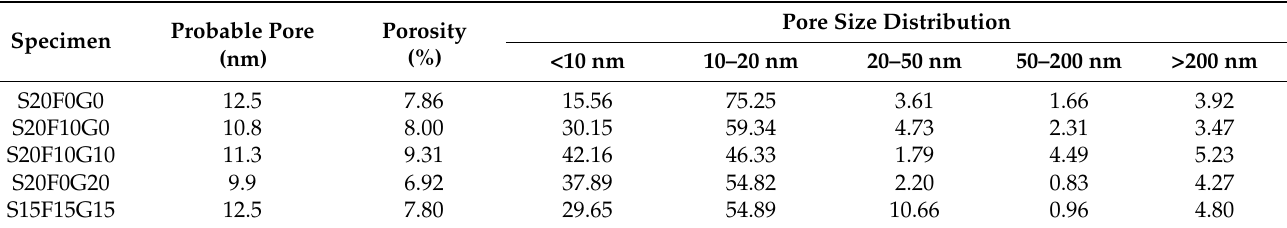
Table 5. The pore structure of EUHPC under standard curing.